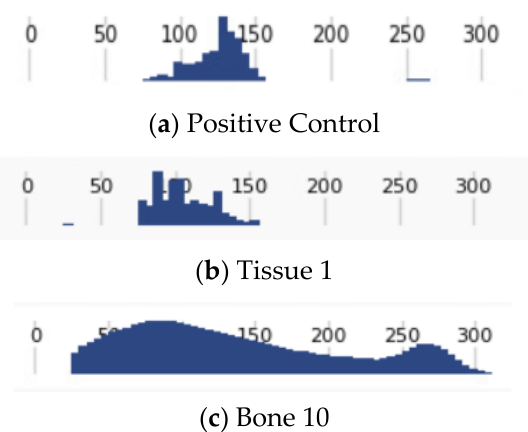
Figure 3. Read histogram from sequencing report. This histogram shows the size of the reads within a sample. ( a ) Histogram for a positive control sample. ( b ) Histogram for tissue 1 showing degradation. ( c ) Histogram for bone sample 10.